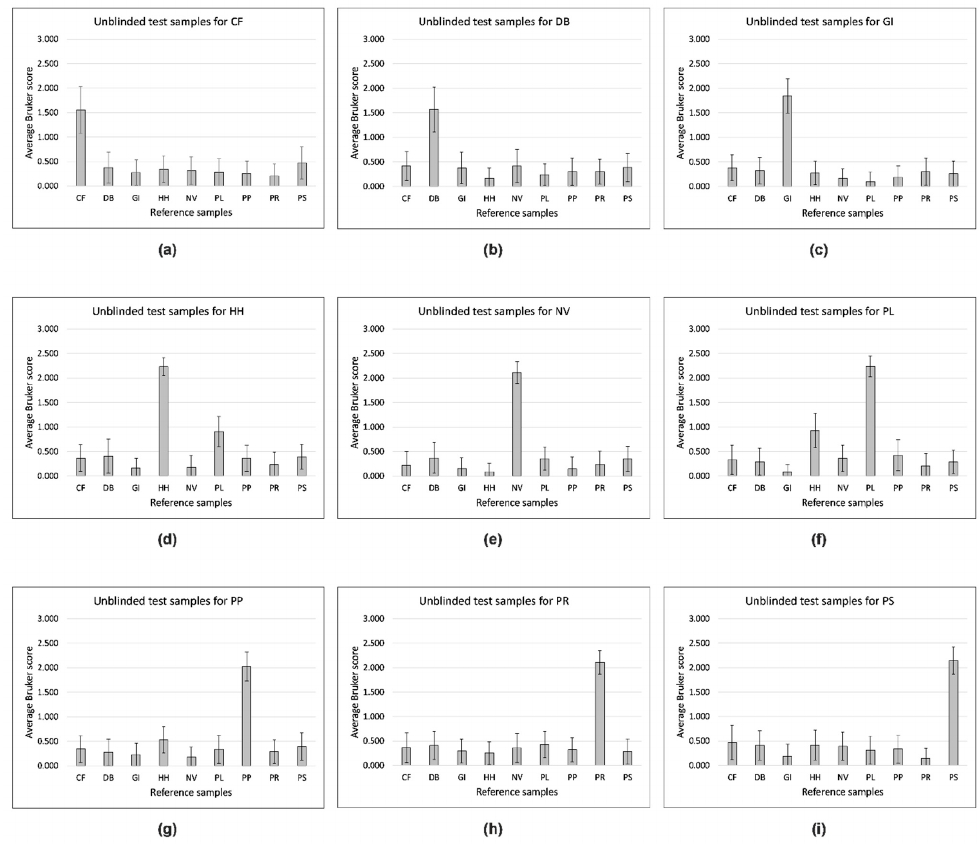
Figure 2. Average Bruker score values and standard errors for all 81 pairwise species comparisons. CF = Carpocoris fuscispinus , DB = Dolycoris baccarum , GI = Graphosoma italicum , HH = Halyomorpha halys , NV = Nezara viridula , PL = Piezodorus lituratus , PP = Palomena prasina , PR = Pentatoma rufipes , and PS = Peribalus strictus.